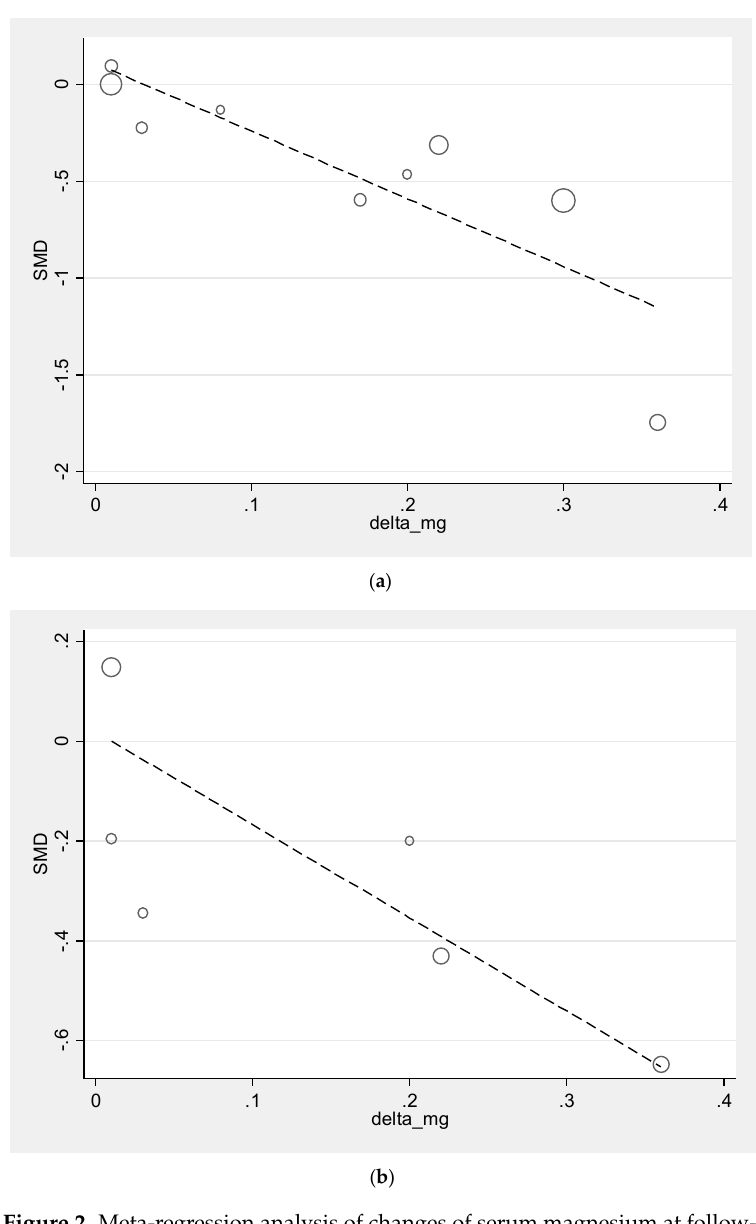
Figure 2. Meta-regression analysis of changes of serum magnesium at follow-up (treated vs. placebo) and ( a ) fasting plasma glucose and( b ) HOMA-IR.